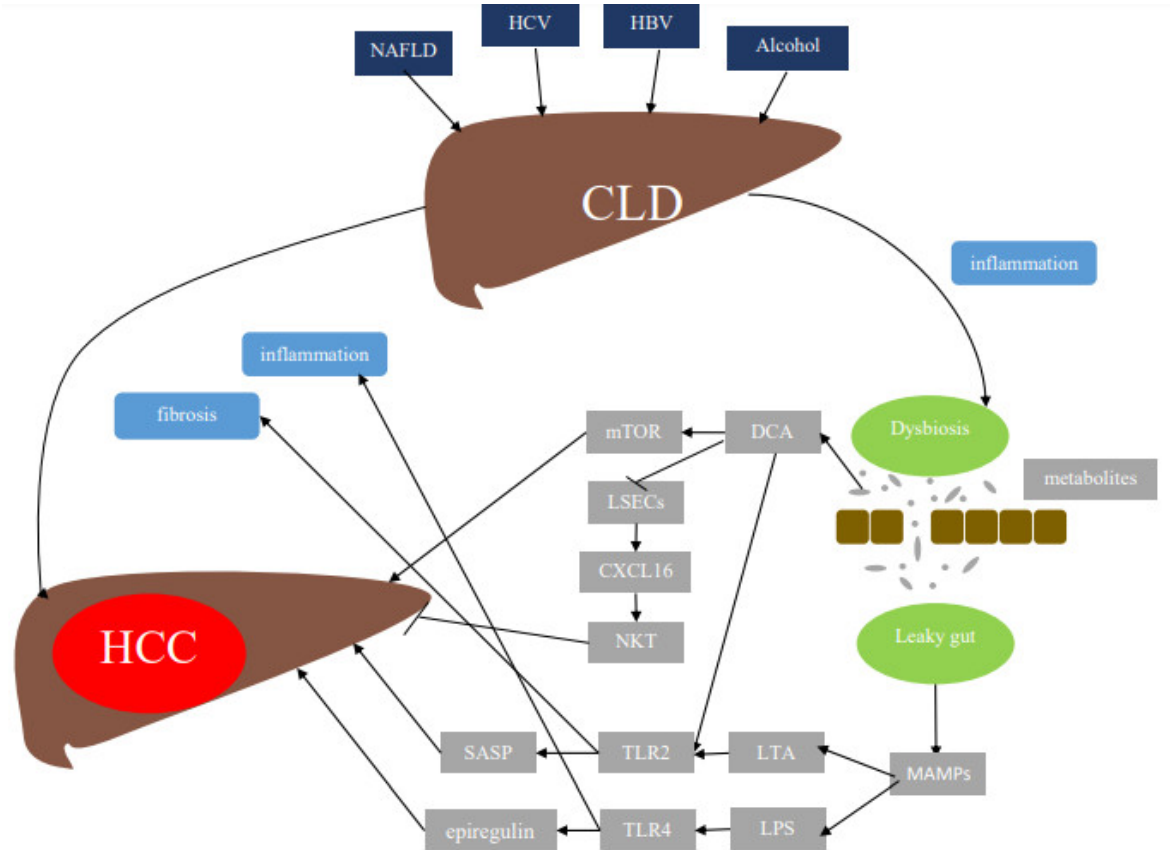
Figure 1. Mechanisms by which the gut microbiome plays a role in hepatocellular carcinoma. Besides the known risk factors for HCC, which include NAFLD, HBV, HCV, and alcohol, dysbiosis and leaky gut resulting from dysfunctional microbiota represent two other major factors leading to hepatic carcinogenesis. As such, several pathways are initiated, leading to HCC, which are detailed above. HCC: hepatocellular carcinoma; CLD: chronic liver disease; NAFLD: non-alcoholic